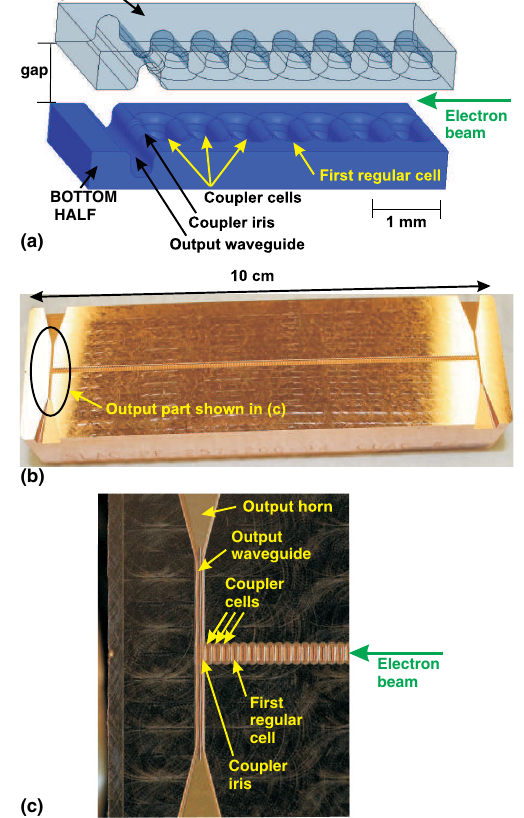
FIG. 1. Solid model of the output section of the 200 GHz traveling-wave accelerating structure (a), picture of one-half of the Cu-Ag structure (b), and picture of the output section of the